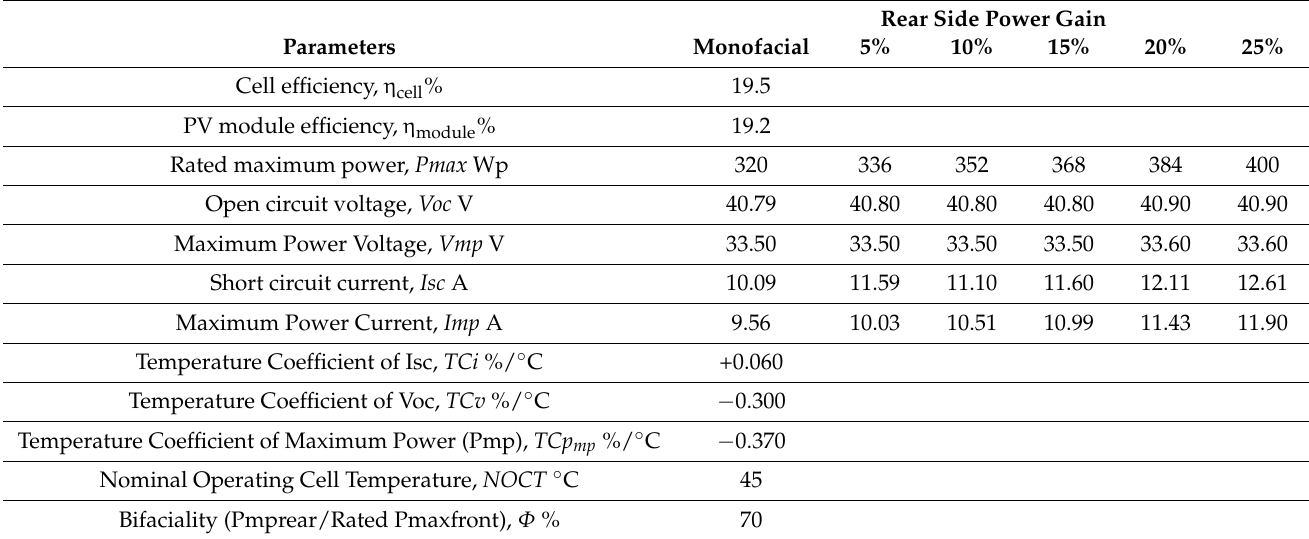
Table 1. The electrical parameters at Standard Test Conditions (STC) of the bifacial PV module with different irradiance conditions on the module’s backside; the rear-side power gain had a linear relationship to the parameters Isc and Imp , and Voc and Vmp were considered